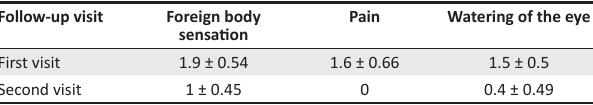
TABLE 1: The patients’ subjective evaluation of postoperative